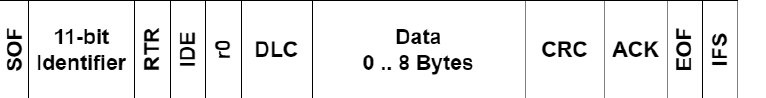
Figure 28. Fields of Standard CAN Frame. A detailed description of every field can be found in